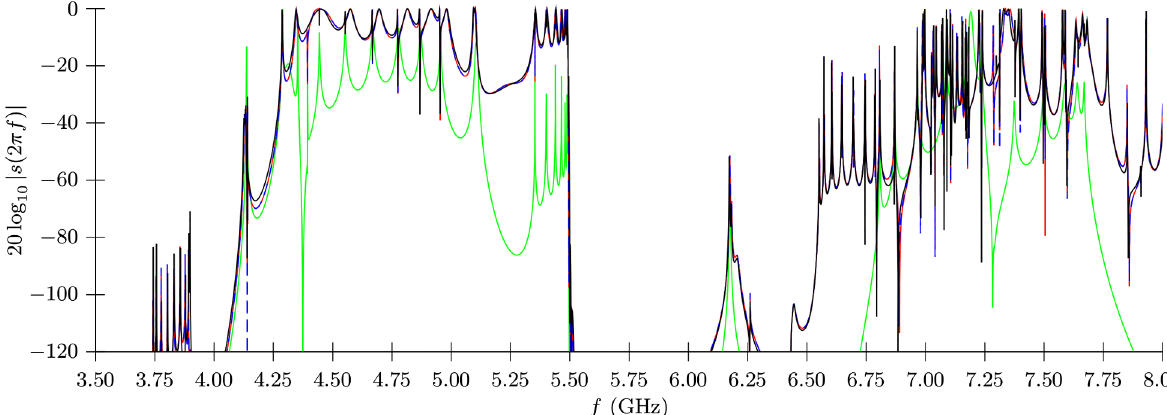
FIG. 6. Modal number convergence test for the CSC procedure: Transmission through test structure (two one-leg HOM couplers without input coupler and third harmonic cavity in between) from left to right HOM coupler. The ends of the beam pipes are short circuited. Green line: insufficiently computed transmission obtained by CSC with one port mode considered at the decomposition planes. Red line: superior approximation if five port modes are considered. Dashed blue line: excellent fit if ten port modes are considered. Black line: reference transmission computed via full discretization of the structure using the CST Resonant Fast S-Parameter